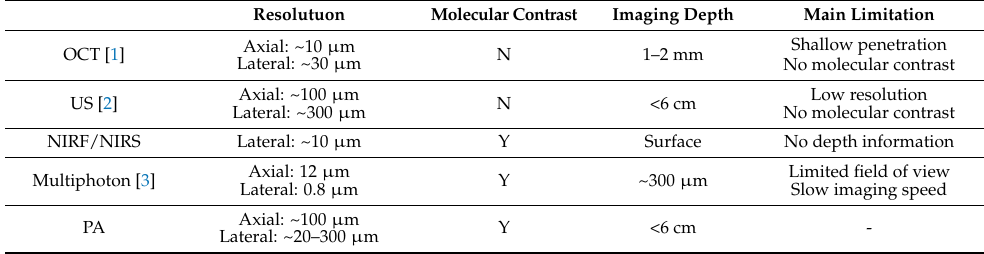
Table 1. Performance comparison of endoscopic imaging